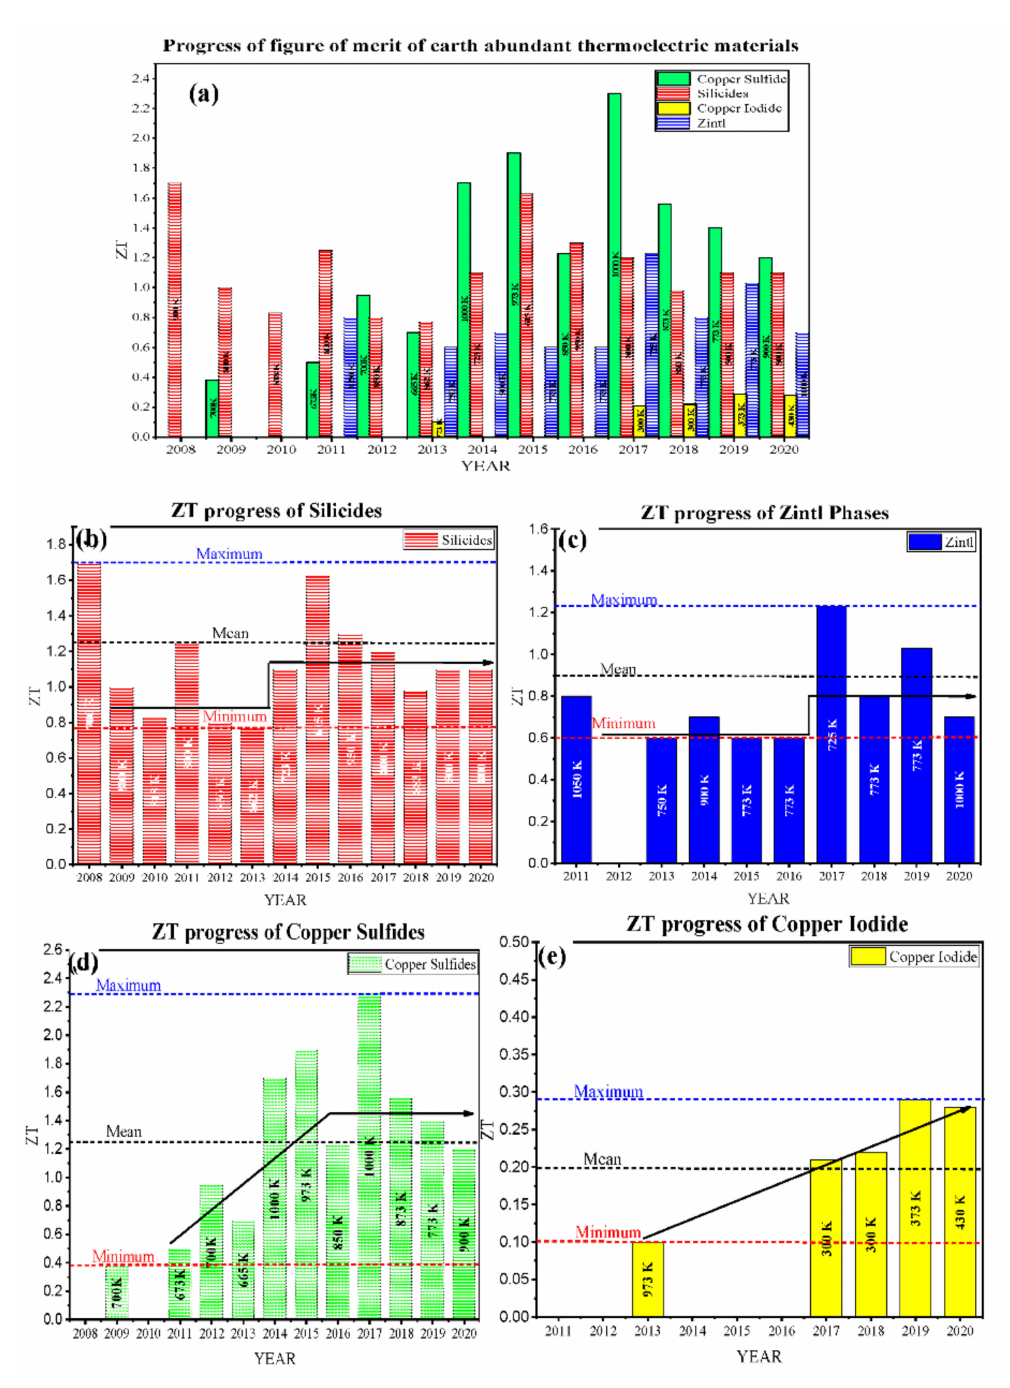
Figure 1. ( a ) Recent progress of figure of merit (ZT max ) of Earth-abundant low-toxic thermoelectric materials; Low- temperature thermoelectric materials (copper iodide and its alloys), Intermediate and high-temperature thermoelectric materials (copper sulfides, silicides, Zintl compounds, and their alloys) from the year 2008–2020. The temperatures at which the maximum ZT recorded is mentioned in the bar-charts. ( b ) silicides, ( c ) Zintl compounds, ( d ) copper sulfides, ( e ) copper iodide (Tables 1 and